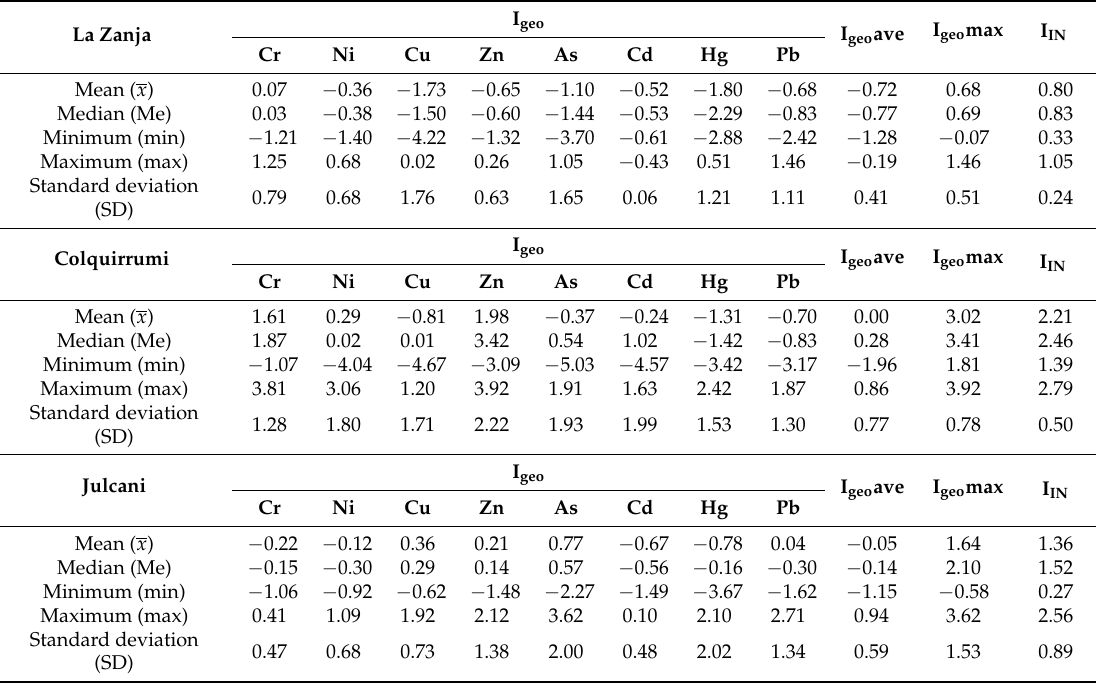
Table 4. Indexes of geo-accumulation (I geo ) of heavy metals and improved Nemerow index (I IN ). La